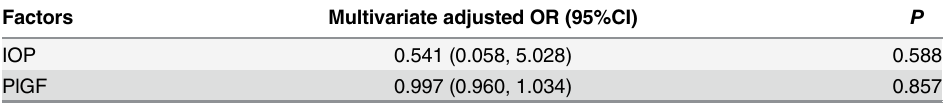
Table 3. Multivariate analysis of risk factors associated with